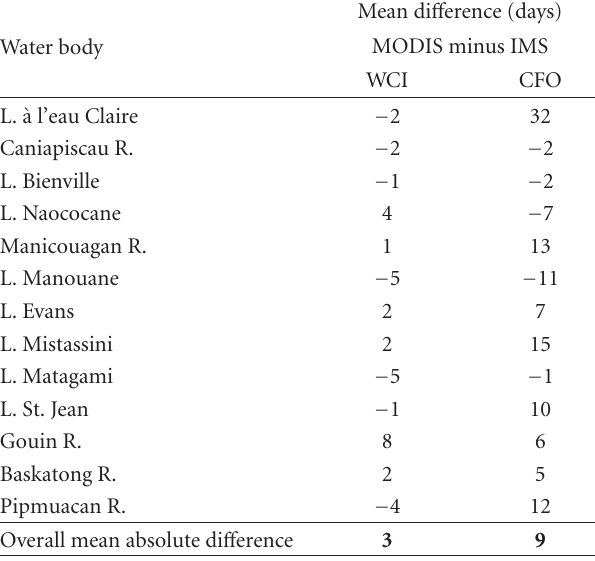
Table 3: Mean di ff erence for 13lakes (L.) or reservoirs (R.), 2004–